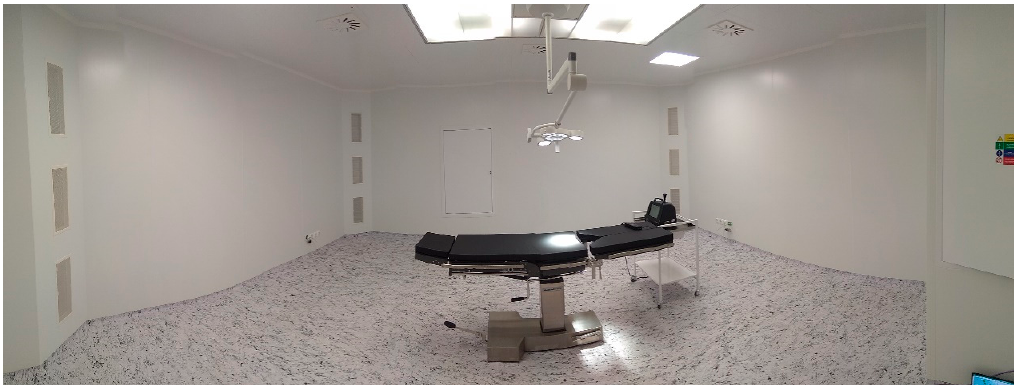
Figure 2. OR equipment. Figure 2. OR